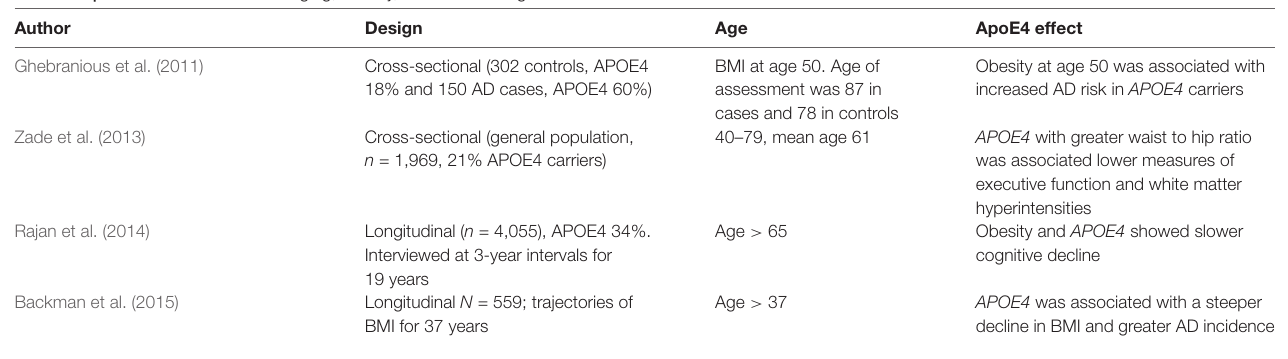
TABLE 2 | The interaction between aging, obesity, APOE4 with cognitive